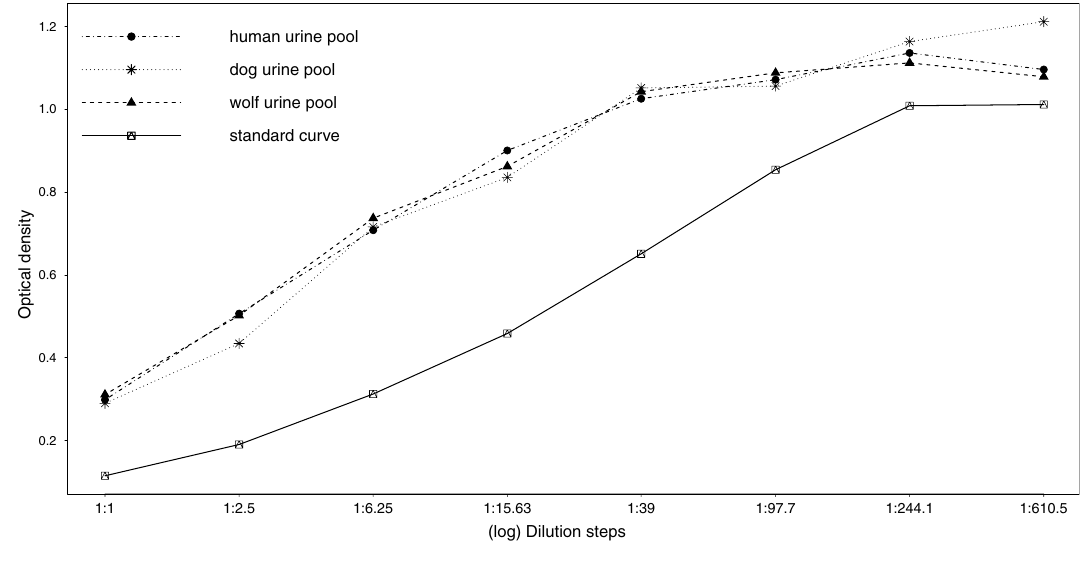
Figure 2. Parallelism of serially diluted human, dog, and wolf urine pool samples to the oxytocin (OT) standard curve. Note that the x-axis is on a log